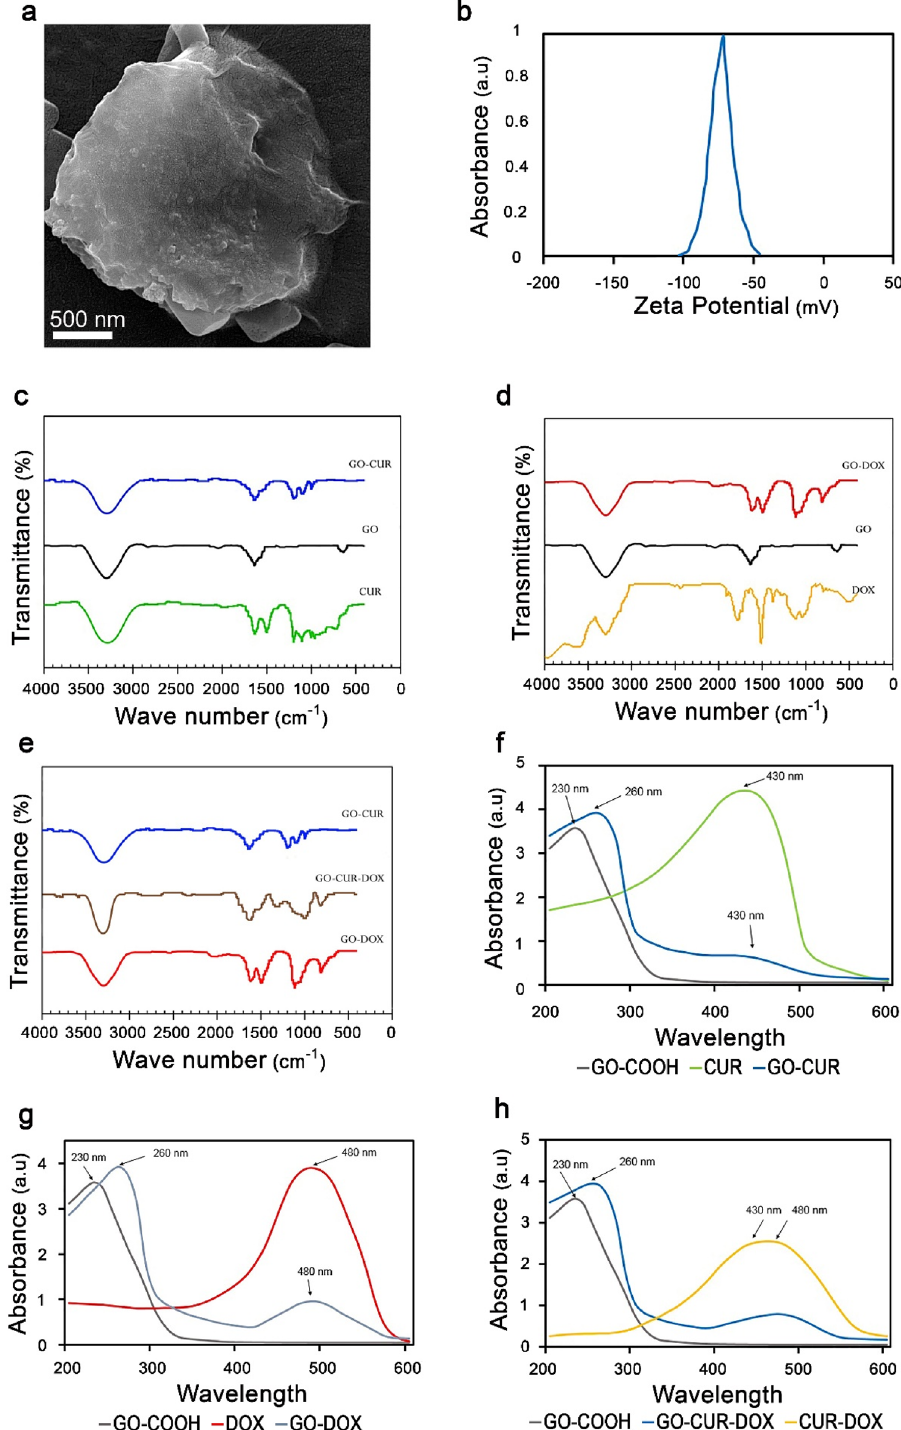
Figure 1. ( a ) SEM image of GO-COOH. ( b ) Zeta potential of GO-COOH. ( c – e ) FTIR of free drugs and GO-COOH-loaded drugs. UV–Vis spectra of ( f ) CUR, GO-COOH, GO-CUR ( g ) DOX, GO-COOH, GO-DOX ( h ) CUR-DOX, GO-COOH,